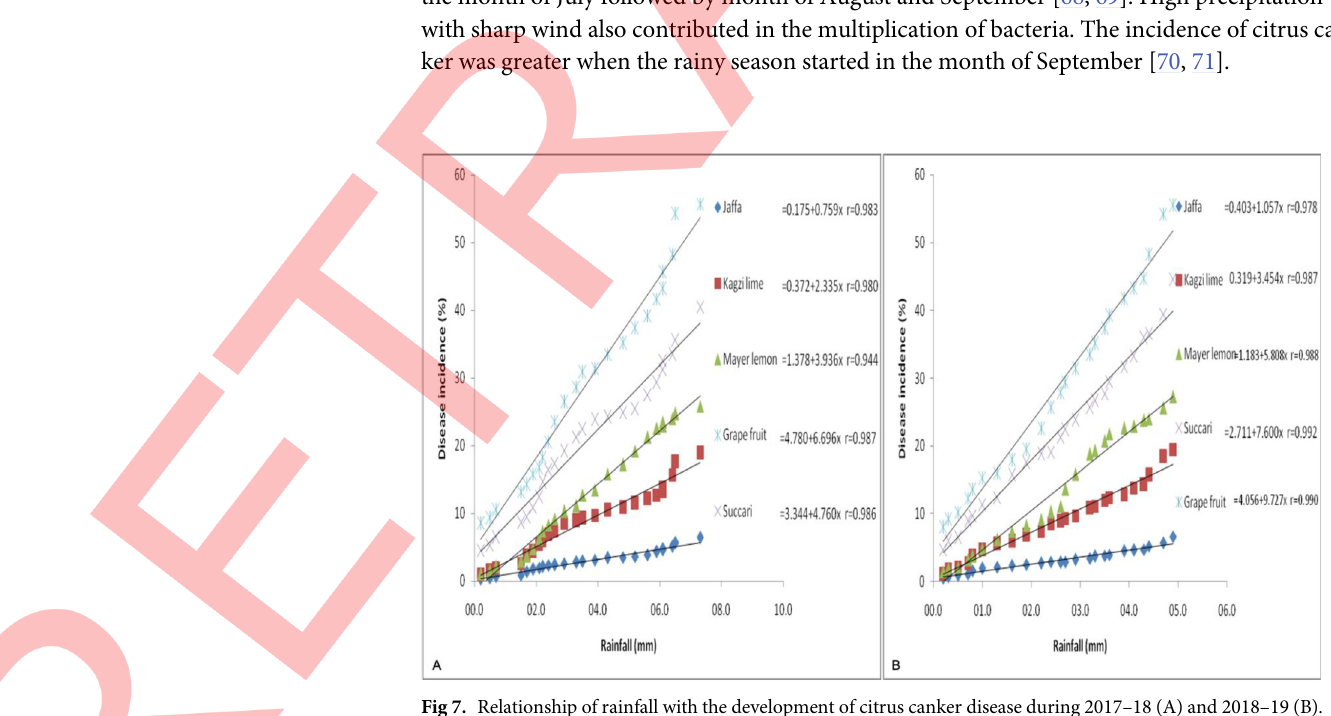
Fig 7. Relationship of rainfall with the development of citrus canker disease during 2017–18 (A) and 2018–19